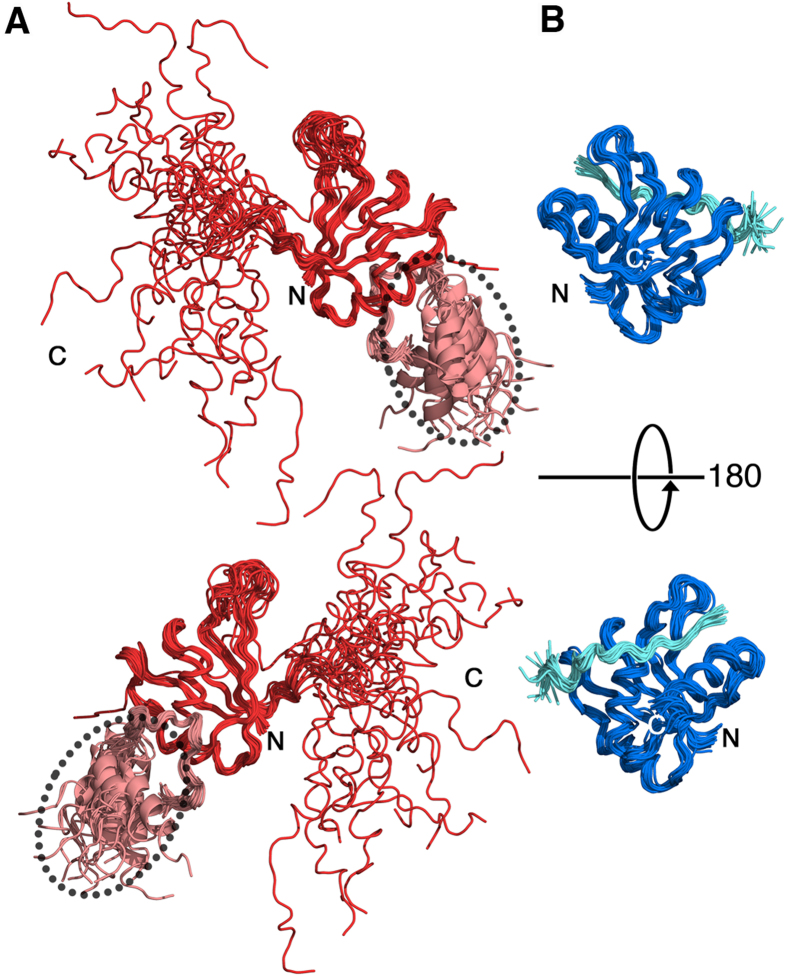
Three-dimensional structures of intermediates during cRES complex assembly.(A) hcBud13p–cSnu17p dimer. 20 lowest-energy structures (backbone atoms only) are shown. Residues 116–131 of Snu17p, which fold into an α-helix in the cRES trimer12, remain flexible in the hcBud13p–cSnu17p dimer. In addition, the relative orientation of the C-terminal α-helix of hcBud13p (marked by a dashed ellipsoid) is flexible. Red, cSnu17p; pink hcBud13p. (B) cPml1p–cSnu17p dimer. Shown are the backbones of the 20 lowest-energy structures of the NMR ensemble. Blue, cSnu17p; cyan cPml1p.